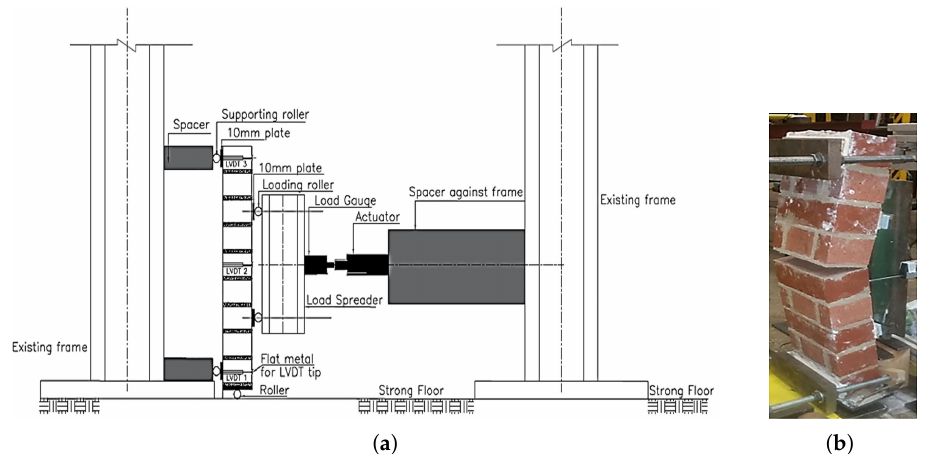
Figure 1. ( a ) The setup for the masonry prisms and ( b ) observed experimental failure (Reprinted with permission from